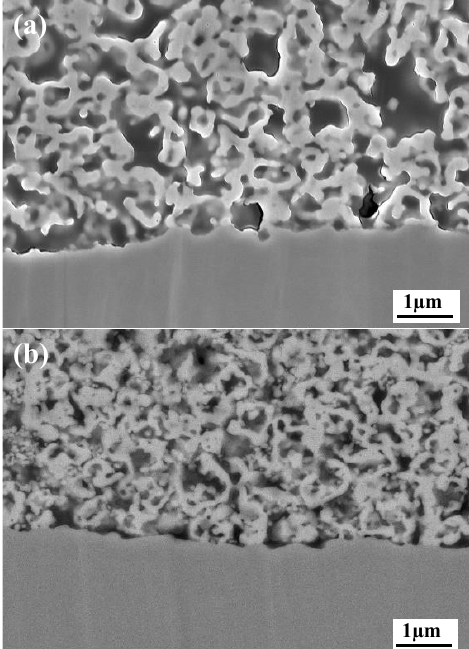
Figure 7. Cross-sectional SEM images of the interfacial microstructure of the sample bonded at 160 °C for 30 min ( a ) with and ( b ) without formic acid vapor.